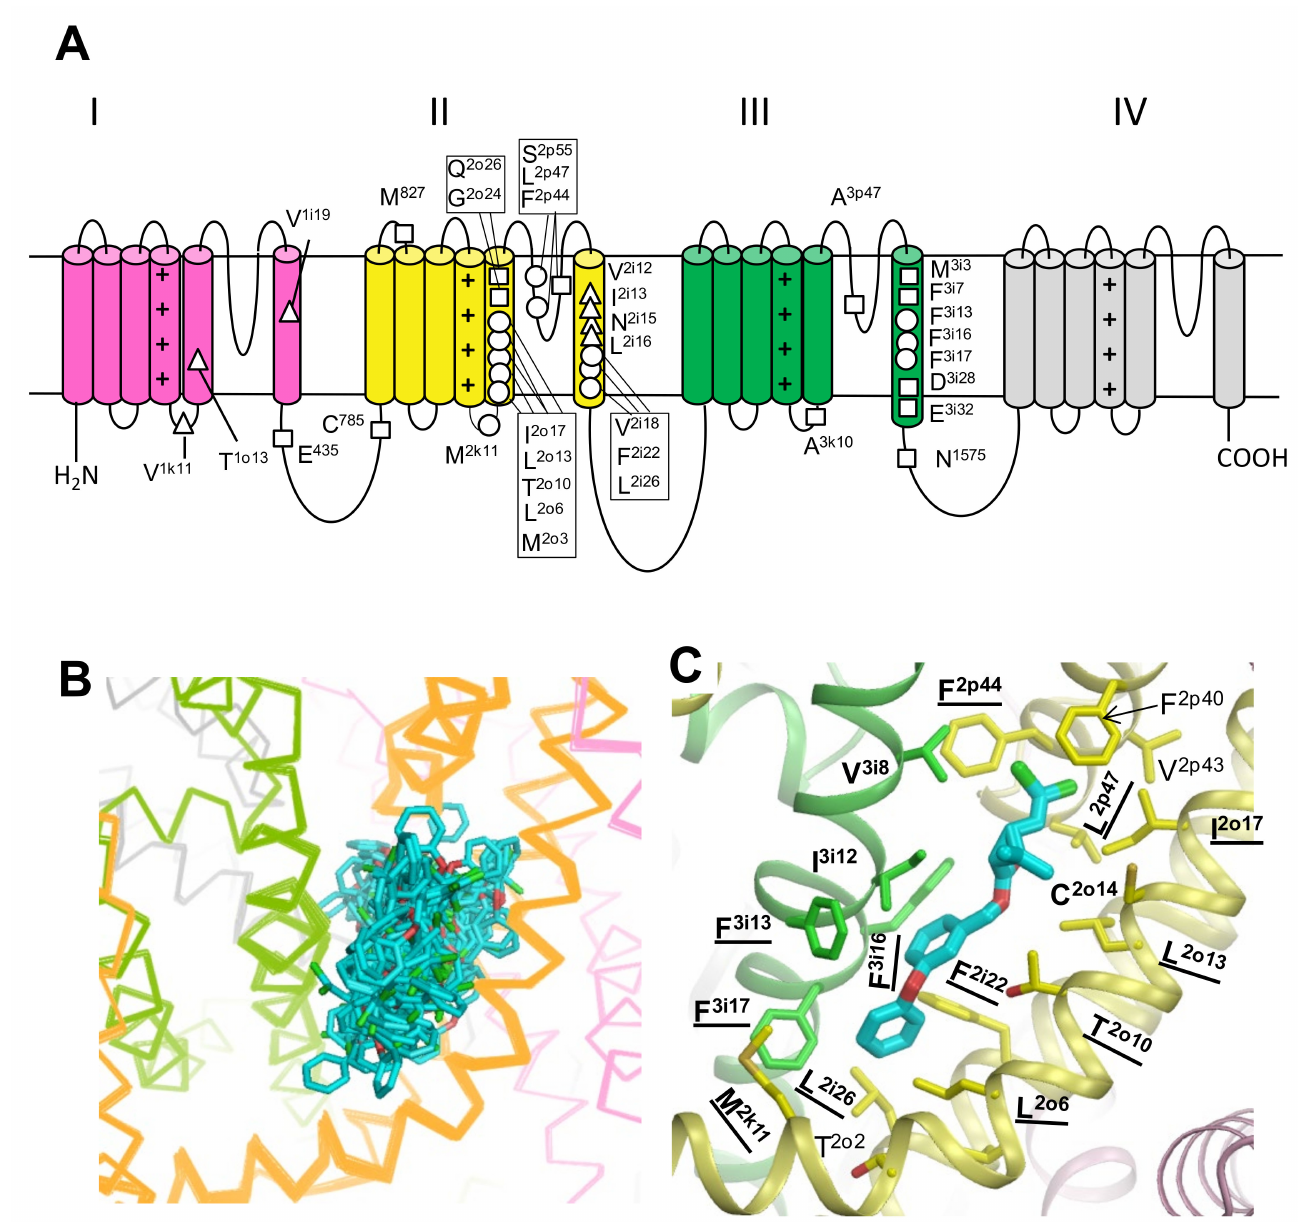
Figure 1. ( A ) Transmembrane topology of voltage-gated insect sodium channels indicating residues within PyR1 (circles) or PyR2 (triangles), or beyond PyR1 and PyR2 (squares), for which kdr mutations have been functionally confirmed in Xenopus oocytes. Residues are labeled according to the scheme, which is universal for P-loop channels [11,23]. A residue label includes the amino acid one-letter code, the domain number (I–IV), segment type ( k , the linker-helix S4–S5; i , the inner helix S6; p , the P-loop; and o , the outer helix S5), and relative number of the residue in the segment. ( B ) Ensemble of PMT starting poses in the PyR1 site of the mosquito sodium channel model with inactivated pore domain, i AaNav1-1. ( C ) A low-energy binding pose of PMT in PyR1. Side chains of residues within 4 Å from PMT are shown as sticks. Labels of residues for which kdr mutations are reported (Table 1) are bold-underlined. Labels of residues for which kdr mutations are unknown, but engineered mutations are shown to affect the action of pyrethroids (Table 2), are